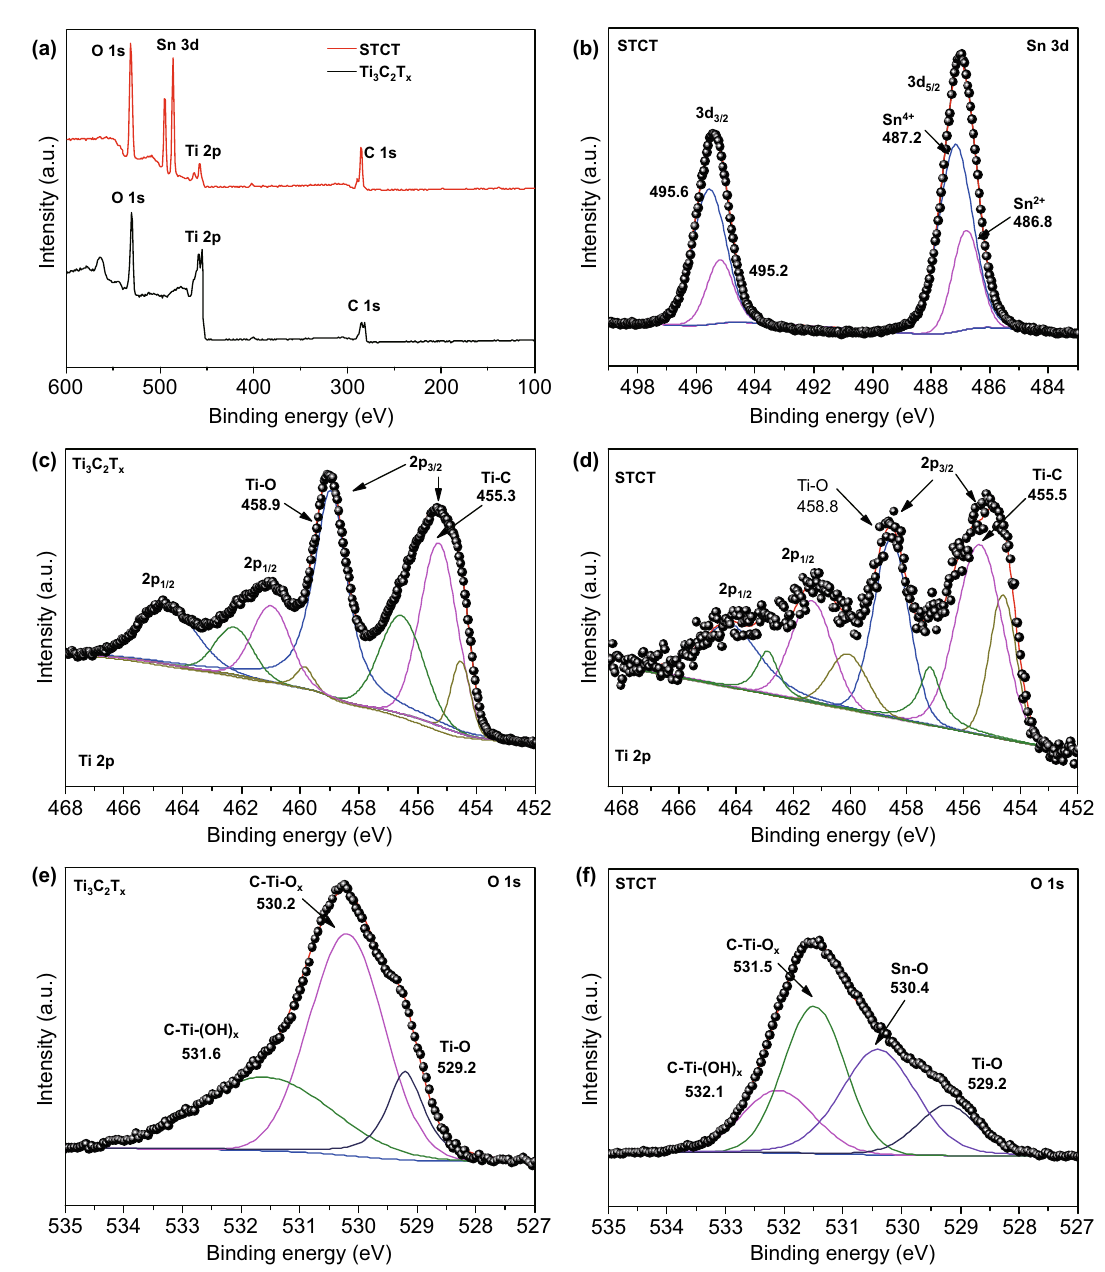
Fig. 4 XPS spectra of a Ti 3 C 2 T x and STCT composites, b high‑resolution Sn 3d spectrum of STCT, c–d high‑resolution Ti 2p spectra of Ti 3 C 2 T x and STCT, and e, f high‑resolution O 1 s spectra of Ti 3 C 2 T x and